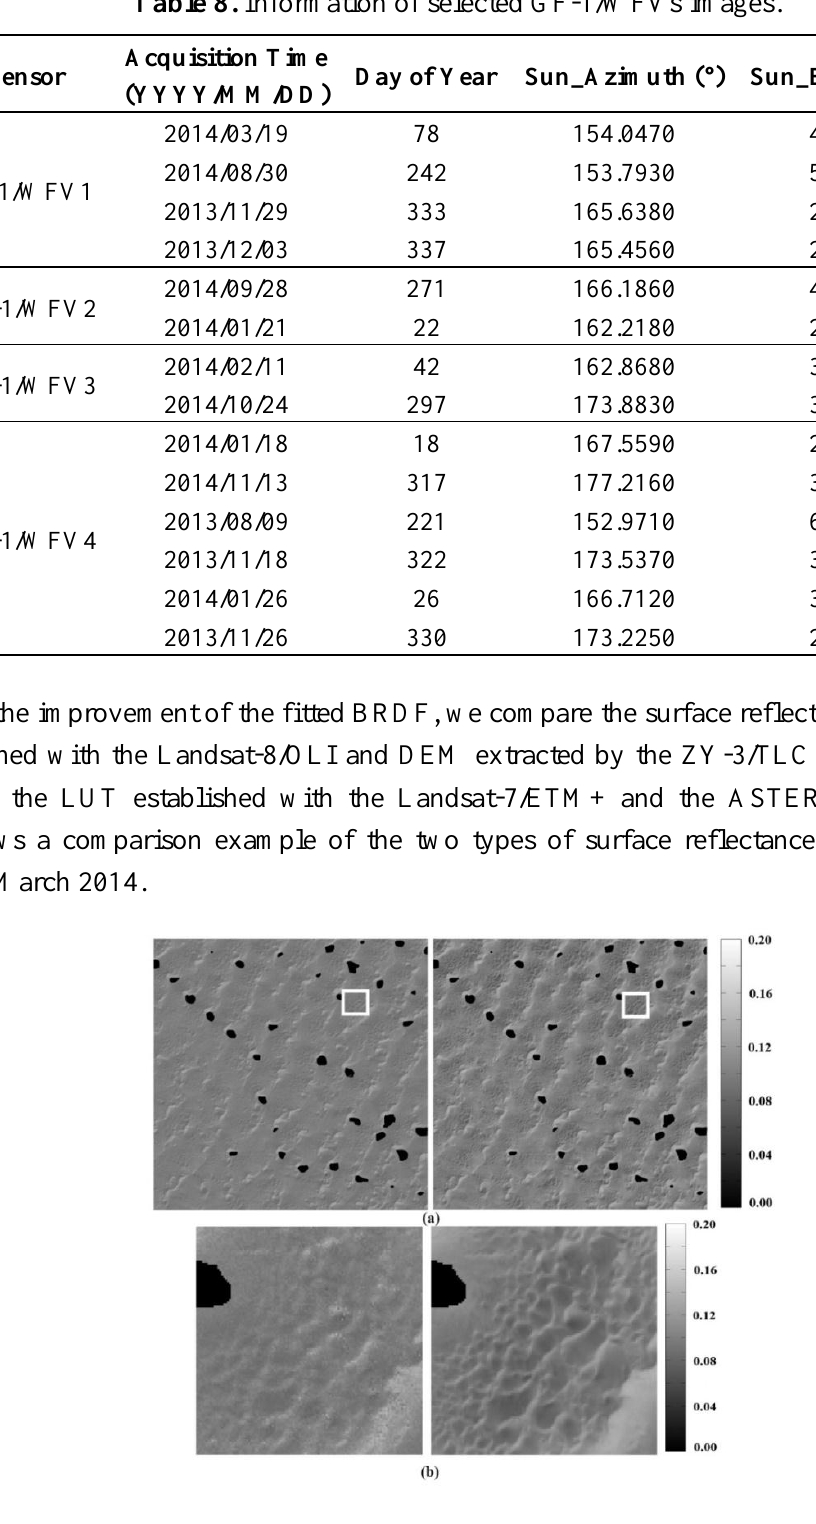
Figure 8. Comparison of the simulated surface reflectance at the blue band on 19March 2014 using the old LUT ( left ) and using the new LUT ( right ). ( a ) Broad view of the simulated surface reflectance and ( b ) close view of the highlighted